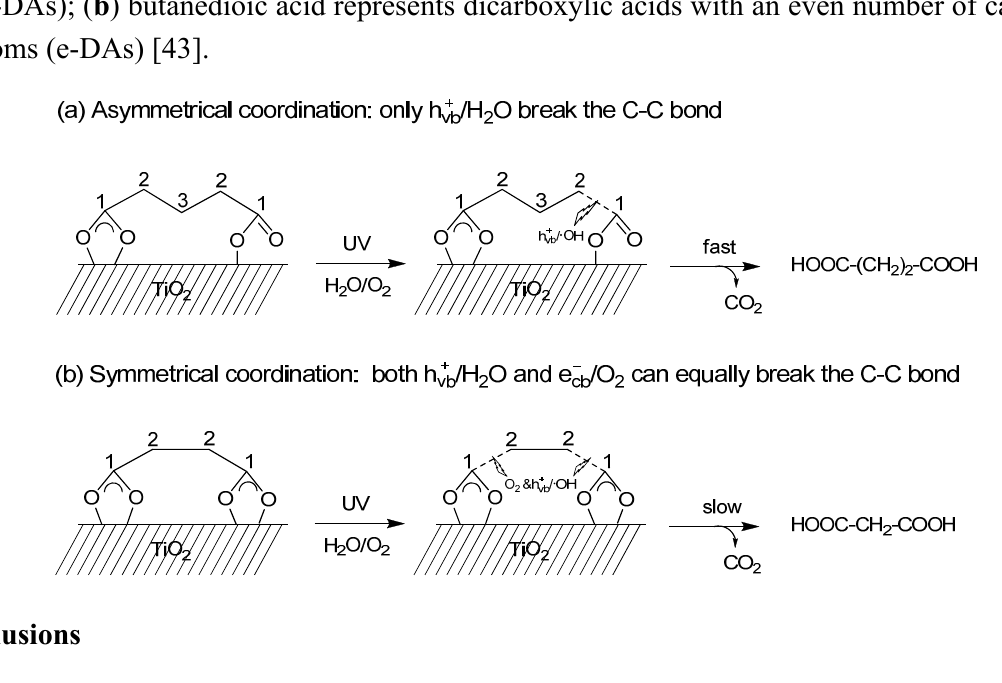
Scheme 13. Schematic diagrams of photoctalytic decarboxylation of dicarboxylic acids. ( a ) Pentanedioic acid represents dicarboxylic acids with an odd number of carbon